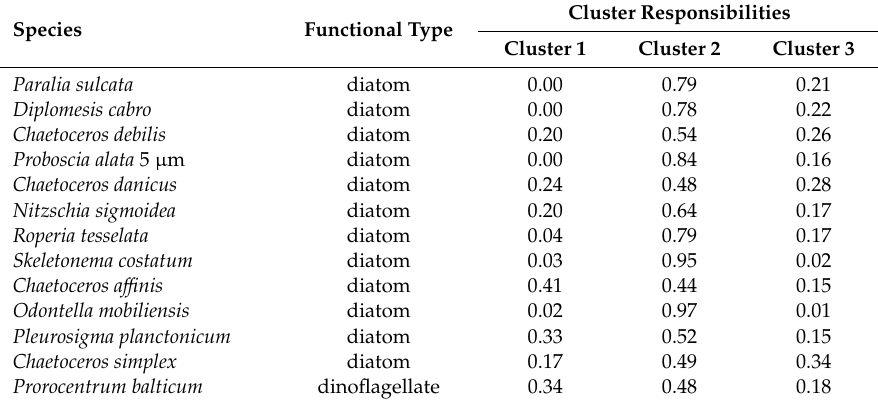
Table A2. List of species assigned to Cluster 2 by the maximum a posteriori clustering solution, their functional types, and their assignment probabilities to the three clusters. This cluster is the smallest in terms of the number of species. It involves 12 diatoms and a single dinoflagellate namely Prorocentrum balticum .